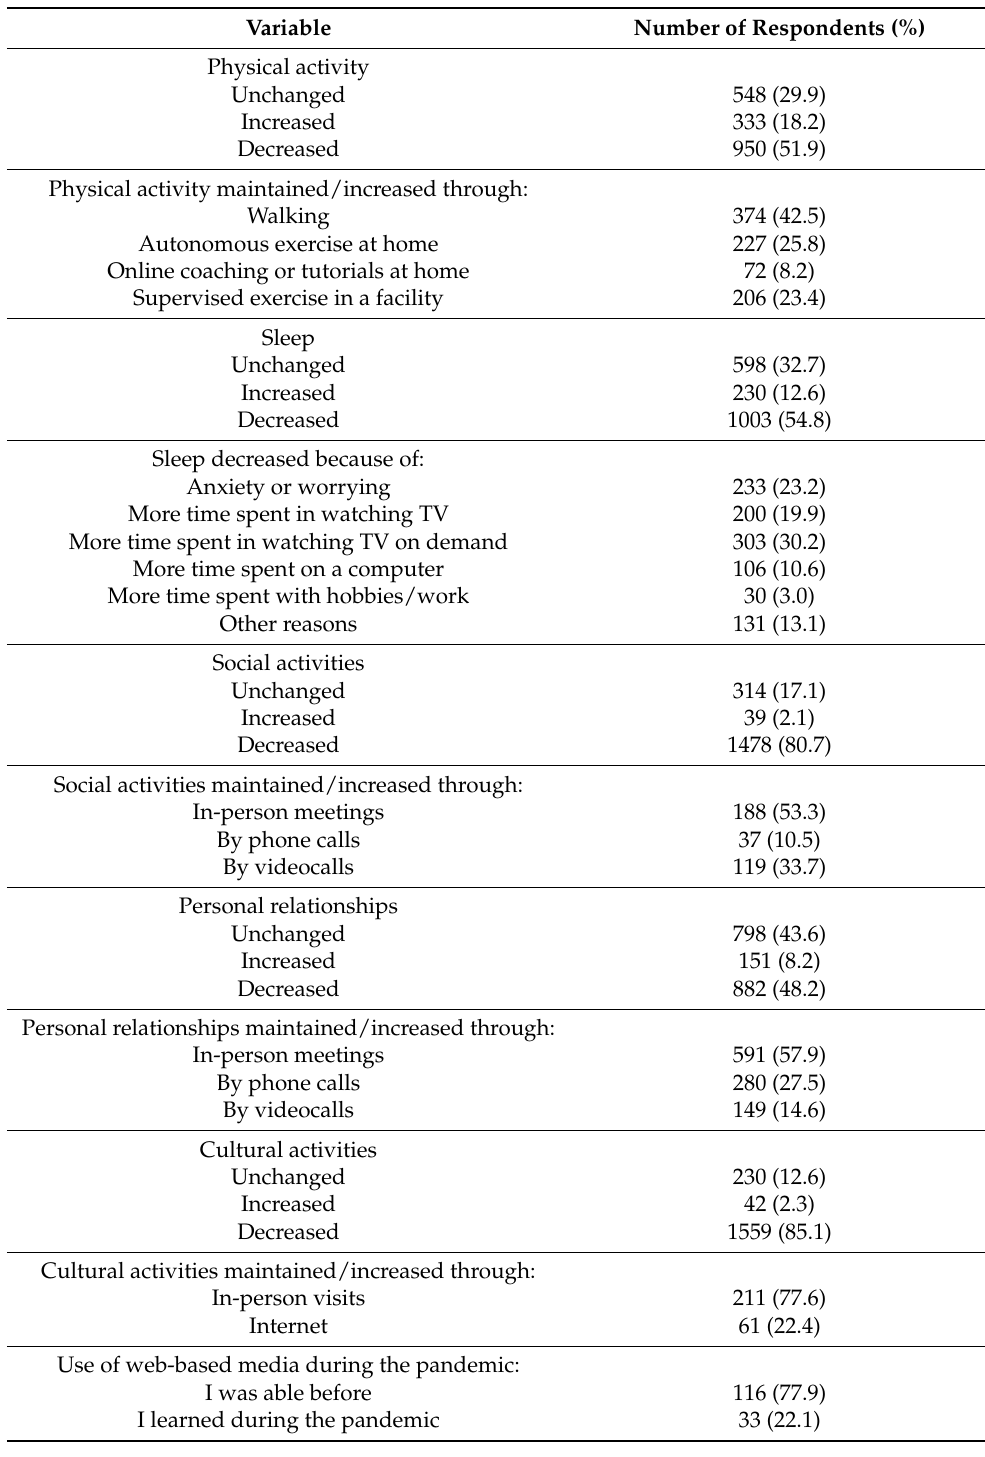
Table 2. Habits assumed during the pandemic by